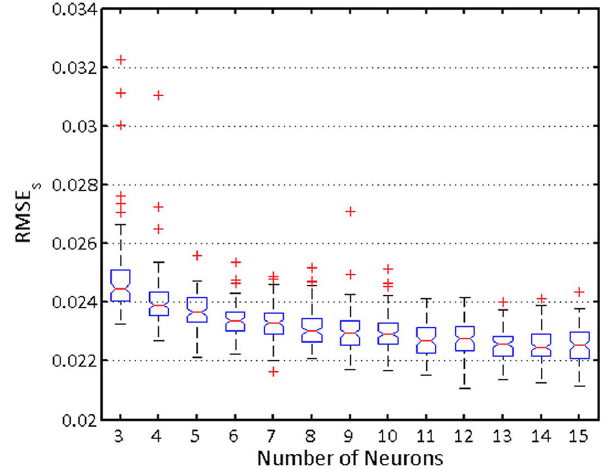
Fig. 5. Box plot of the systematic root mean square error (RMSE s ) of the neural network (ANN Traffic ) calculated from 100 runs for each number of neurons in the hidden layer. The input variables for the model were traffic counts, PAR, air temperature, WD1-9, and four fuzzy variables to describe season and time of day,